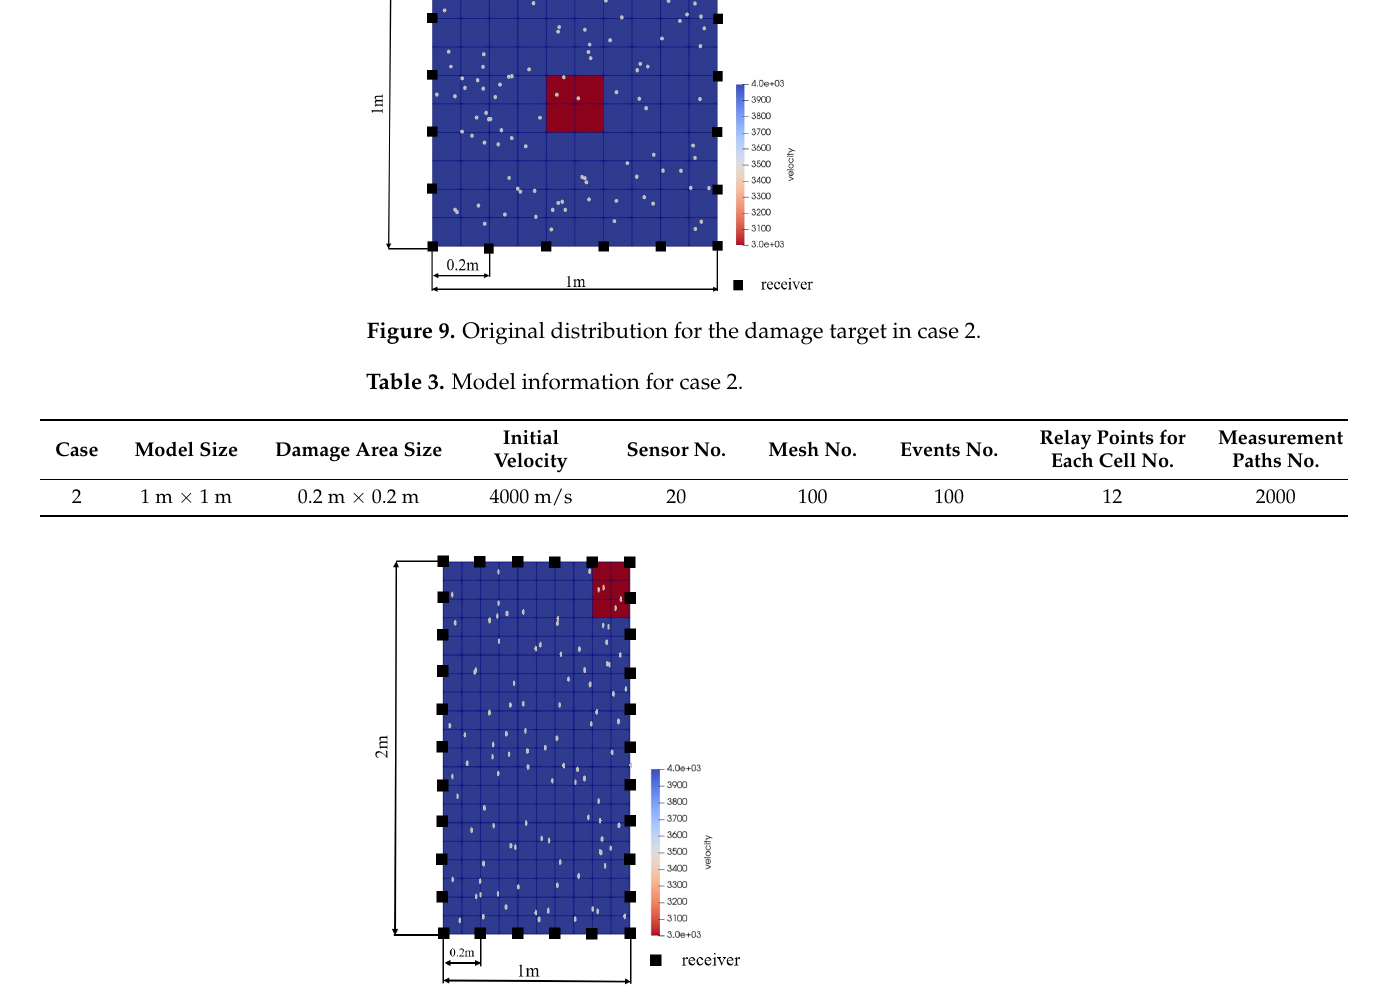
Figure 10. Original distribution for the damage target in case